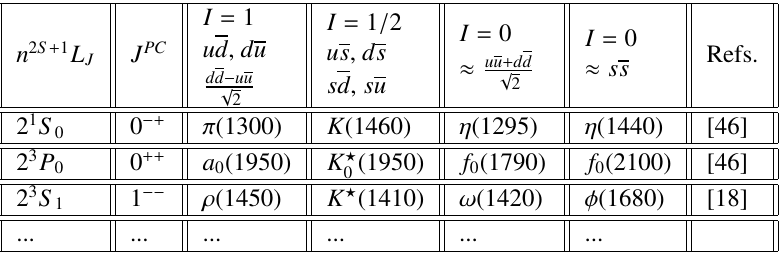
Table 2: Some nonets of conventional radially excited